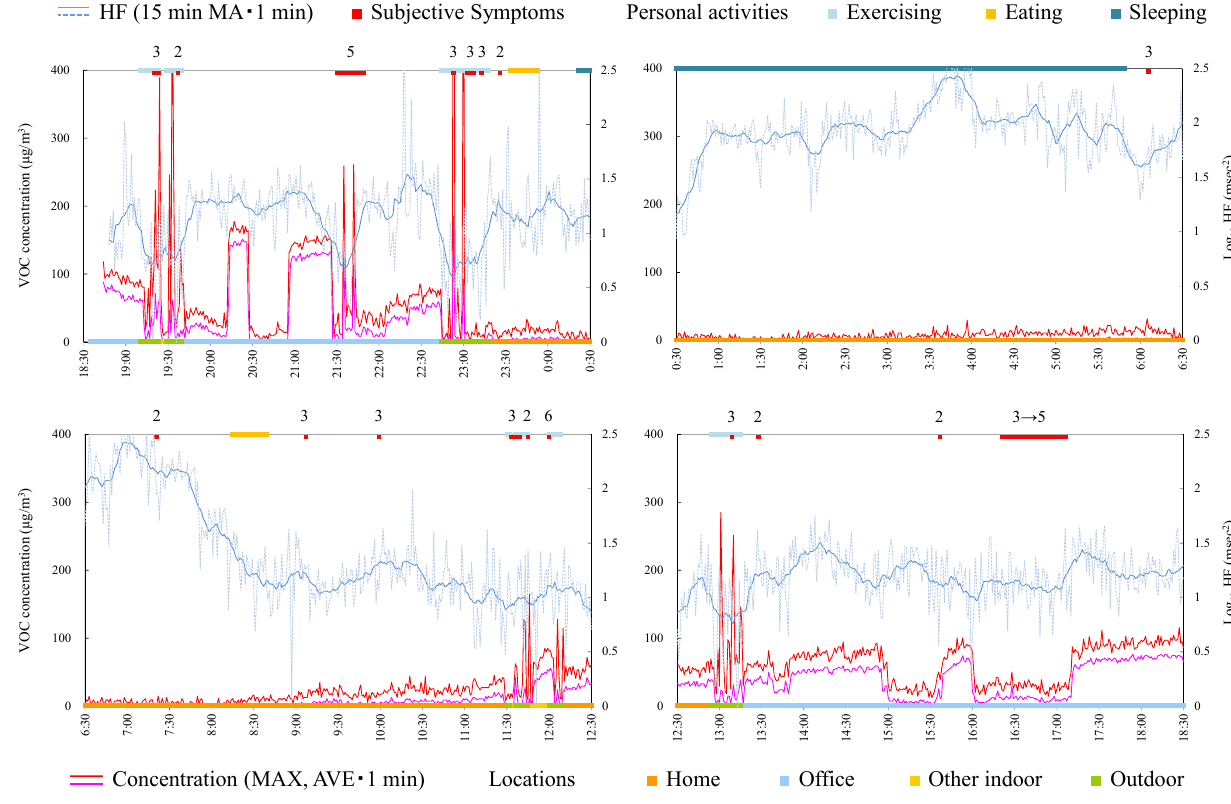
Figure 3. Time-series data of VOC concentration and log 10 HF (subject A). Subjective symptoms and personal activities are indicated in upper side and locations are indicated in lower side. The values on subjective symptoms are symptom